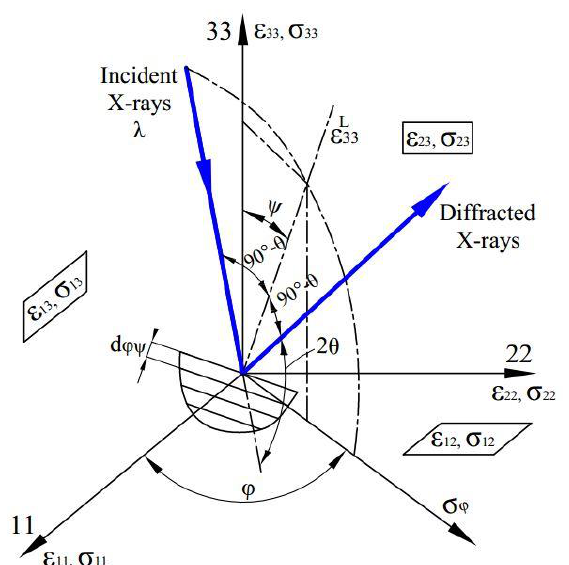
L  and the stresses σ and the stresses σ ij generated in the surface ij generated in the surface layer. 33 33